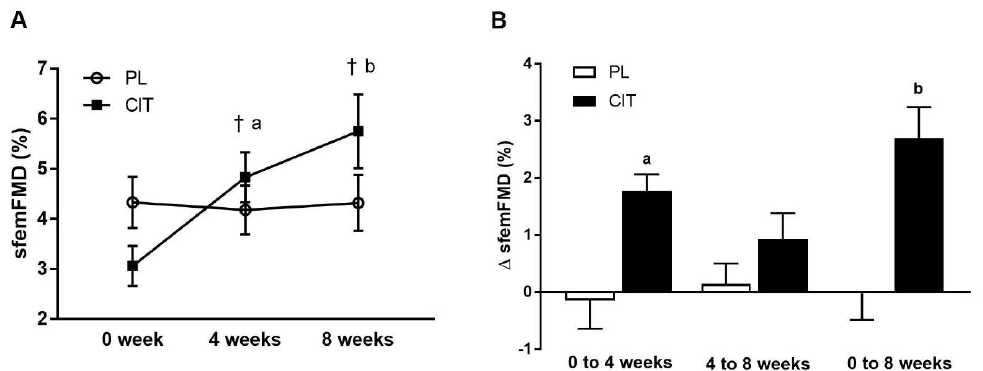
Values are mean ± SE. Abbreviations: PL, placebo; CIT, citrulline; sfemFMD, superficial femoral artery flow-mediated dilation; AUC,areaunderthecurve; faPWV,femoral-anklepulsewavevelocity. p -valuesaregroup-by-timeinteraction from two-way repeated measure analysis of variance. † p < 0.001 vs. 0 week; # p < 0.05 vs. 4 weeks.